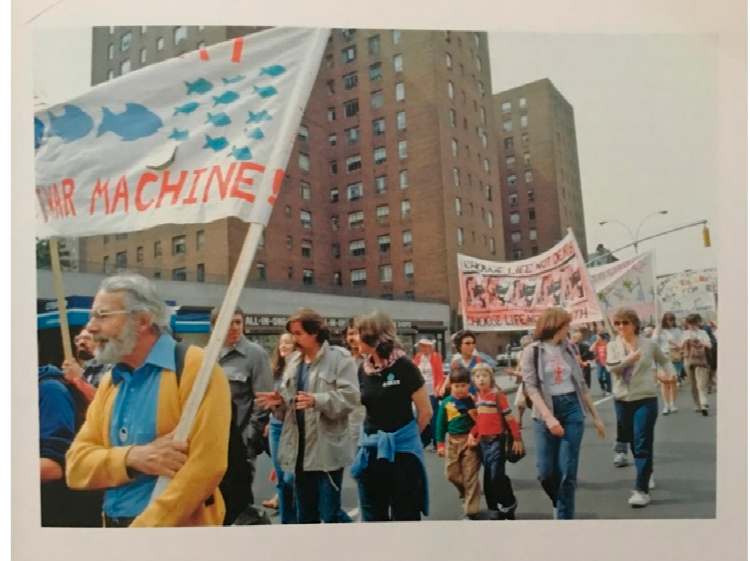
Figure 3. The Silkscreen Project, 1982, collective silkscreen banners with different Latin American solidarity groups, New York. Courtesy of the artist.